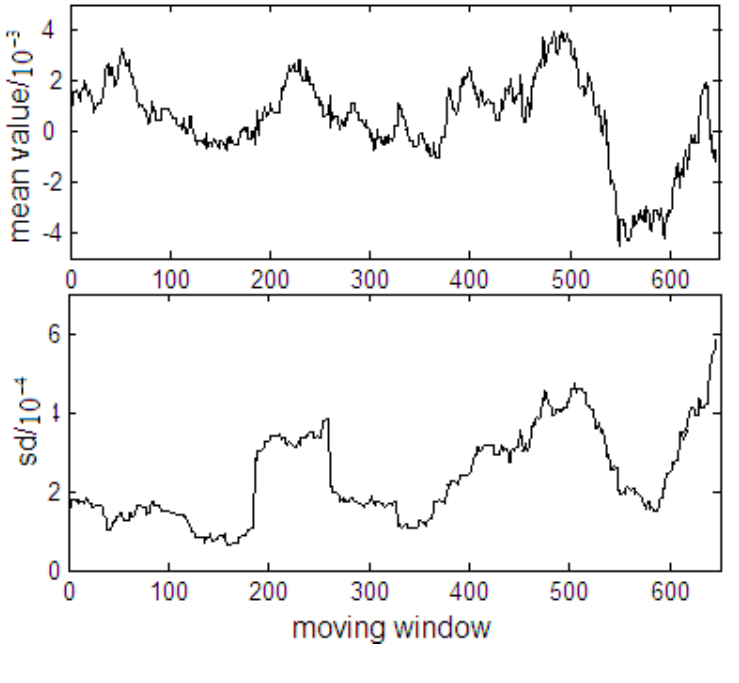
Figure 9. Statistical characteristics for the validation sequence.